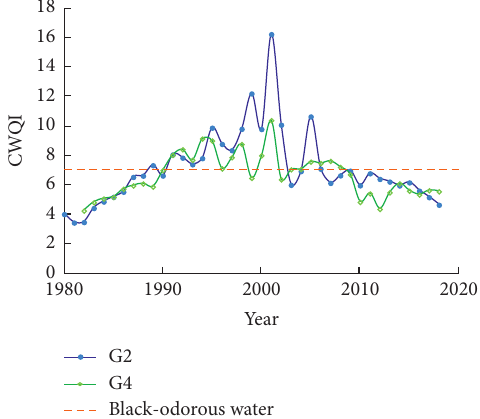
Figure 3: CWQI values at monitoring